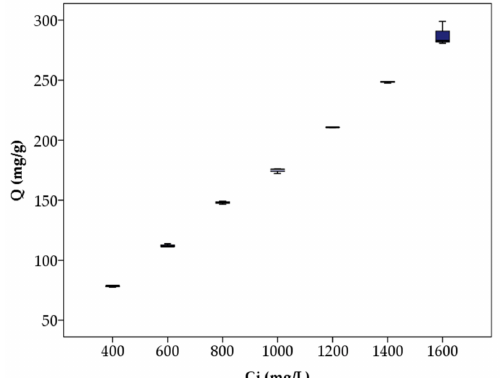
Figure 5. Effect of initial concentration of Cu(II) on adsorption capacity of ion-imprinted polymer.